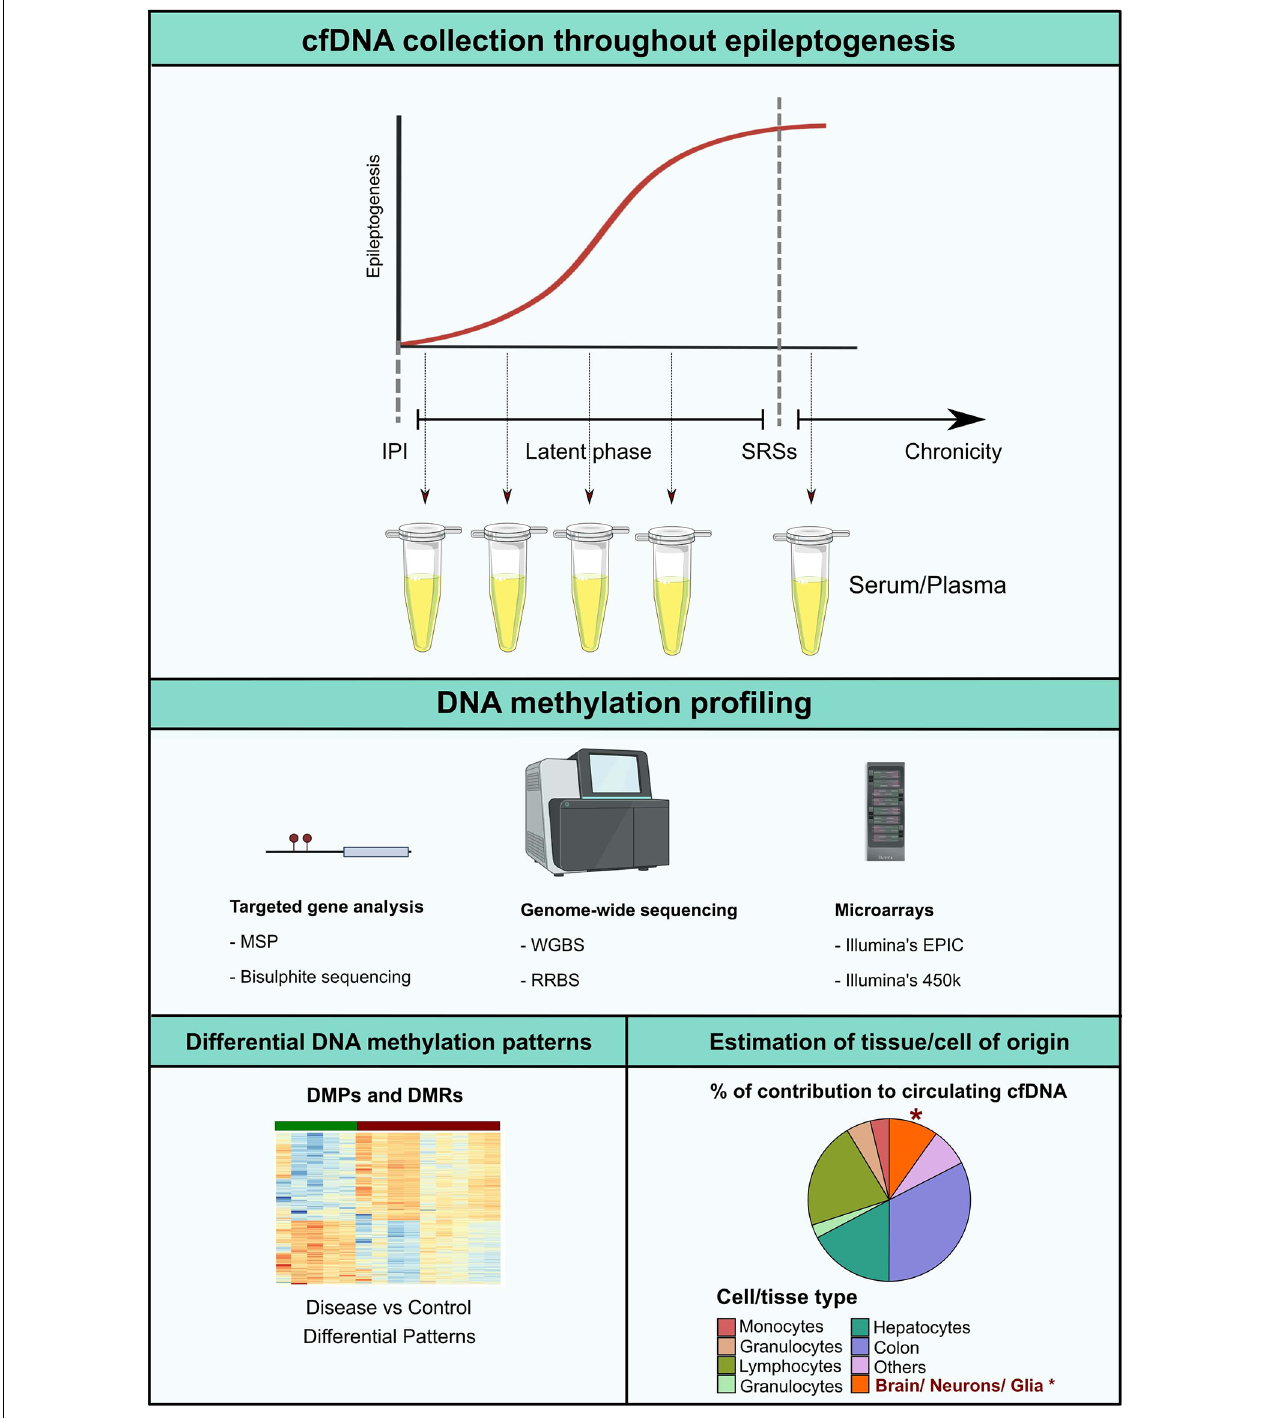
FIGURE 2 | Epileptogenesis is considered to follow a progressive model. After the initial precipitating injury (IPI), the brain parenchyma enters a latent phase in which the ability to generate spontaneous recurrent seizures (SRSs) is established. In the chronic stage, upon initiation of unprovoked seizure activity, epileptogenic molecular and structural remodeling progress with time. DNA methylation profiling along the different timeframes of epileptogenesis would potentially represent a valuable approach for the development of novel non-invasive biomarkers. Possible analytical strategies include detection of altered cfDNA methylation patterns in pathological settings in comparison to controls, or estimation of the percentage of tissue or cell type contribution to the circulating cfDNA pool, which potentially insights on occurring CNS-specific cell death in the early stages of the disease. MSP, Methylation-Specific PCR; RRBS, reduced representation bisulfite sequencing; WBGS, whole genome bisulfite